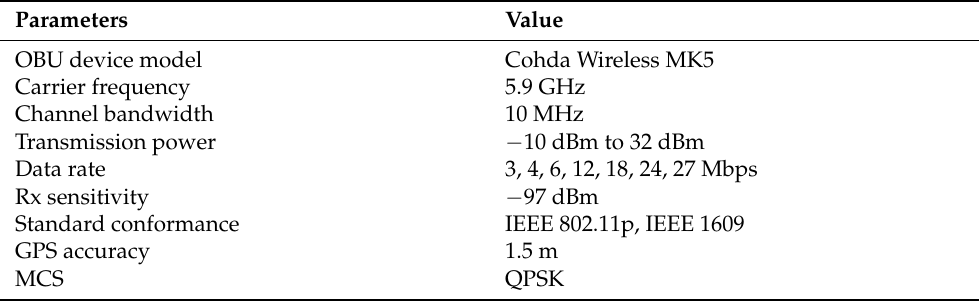
Table 3. Specification of on-board unit (OBU)